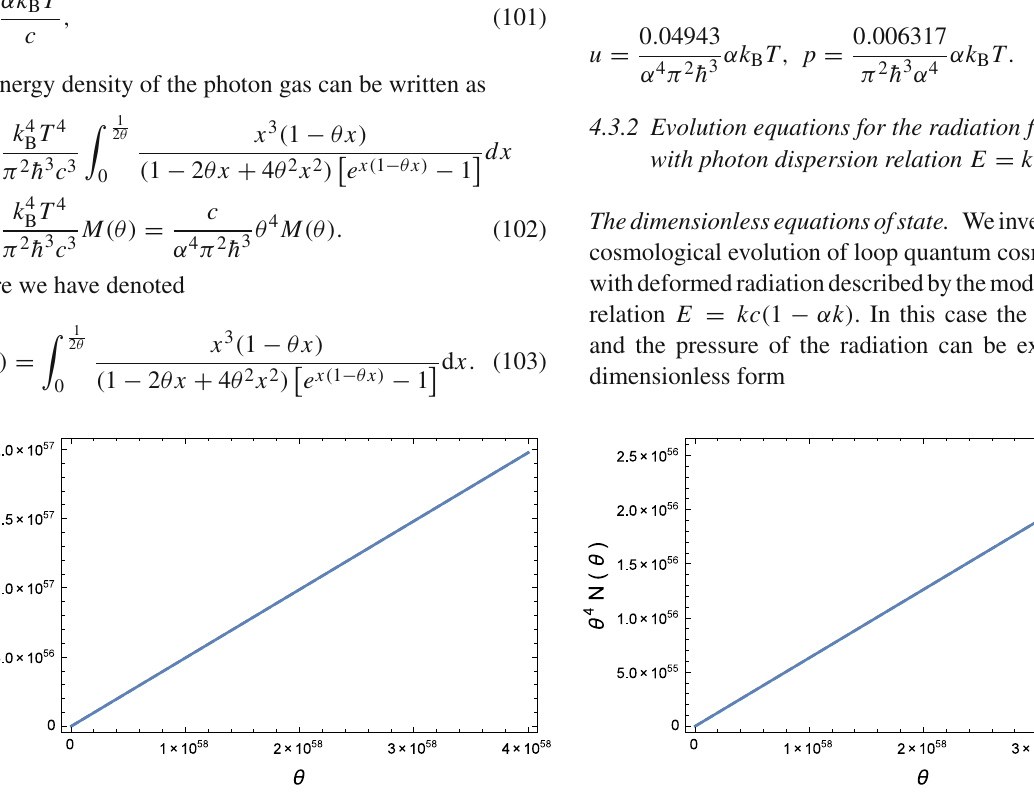
Fig. 8 Variations of the functions θ 4 M (θ) (dotted curve) and 0 . 04943 θ (solid curve) (left figure) and of the functions θ 4 N (θ) (dotted curve) and 0 . 006317 θ (solid curve) (right